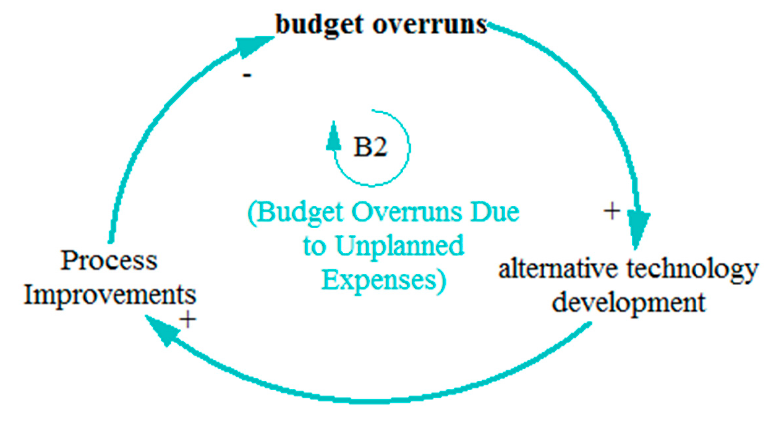
Figure 5. Balancing loop B2 (budget overruns due to unplanned expenses).